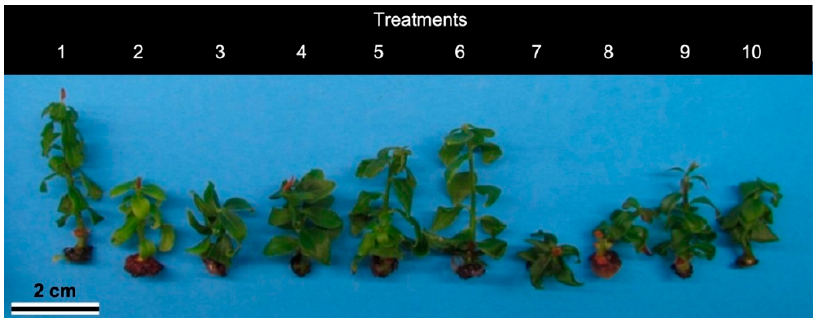
Figure 3. Initial in vitro shoot culture of ‘Delite’ rabbiteye blueberry with 10 treatments. Treatments 1 to 9 with the original Woody Plant Medium (WPM) [18] with different ranges of NH 4 NO 3 (x) and Ca(NO 3 ) 2 · 4H 2 O (x), compared to treatment 10 (modified Woody Plant Medium [15]).